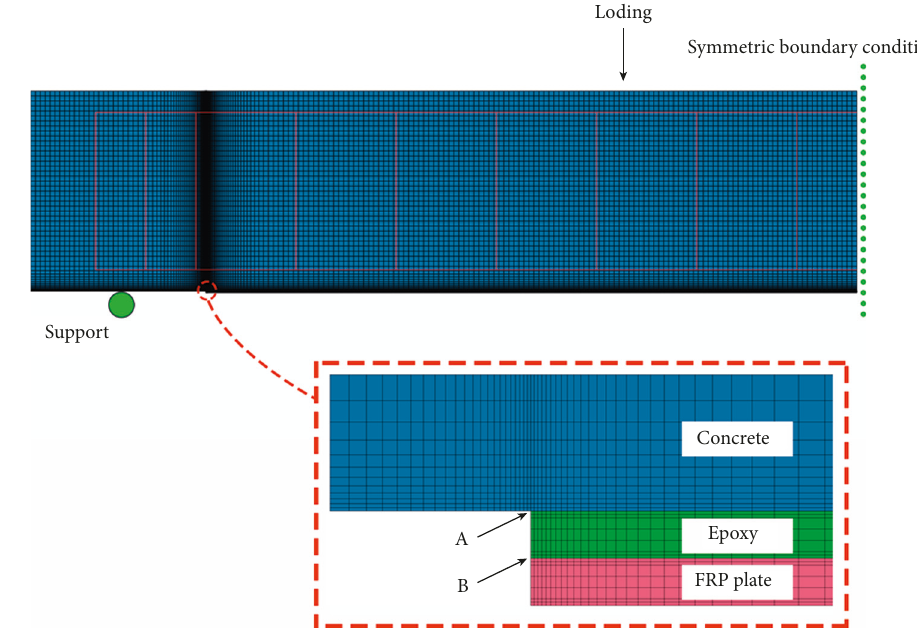
Figure 10: The element refinement near the plate end.